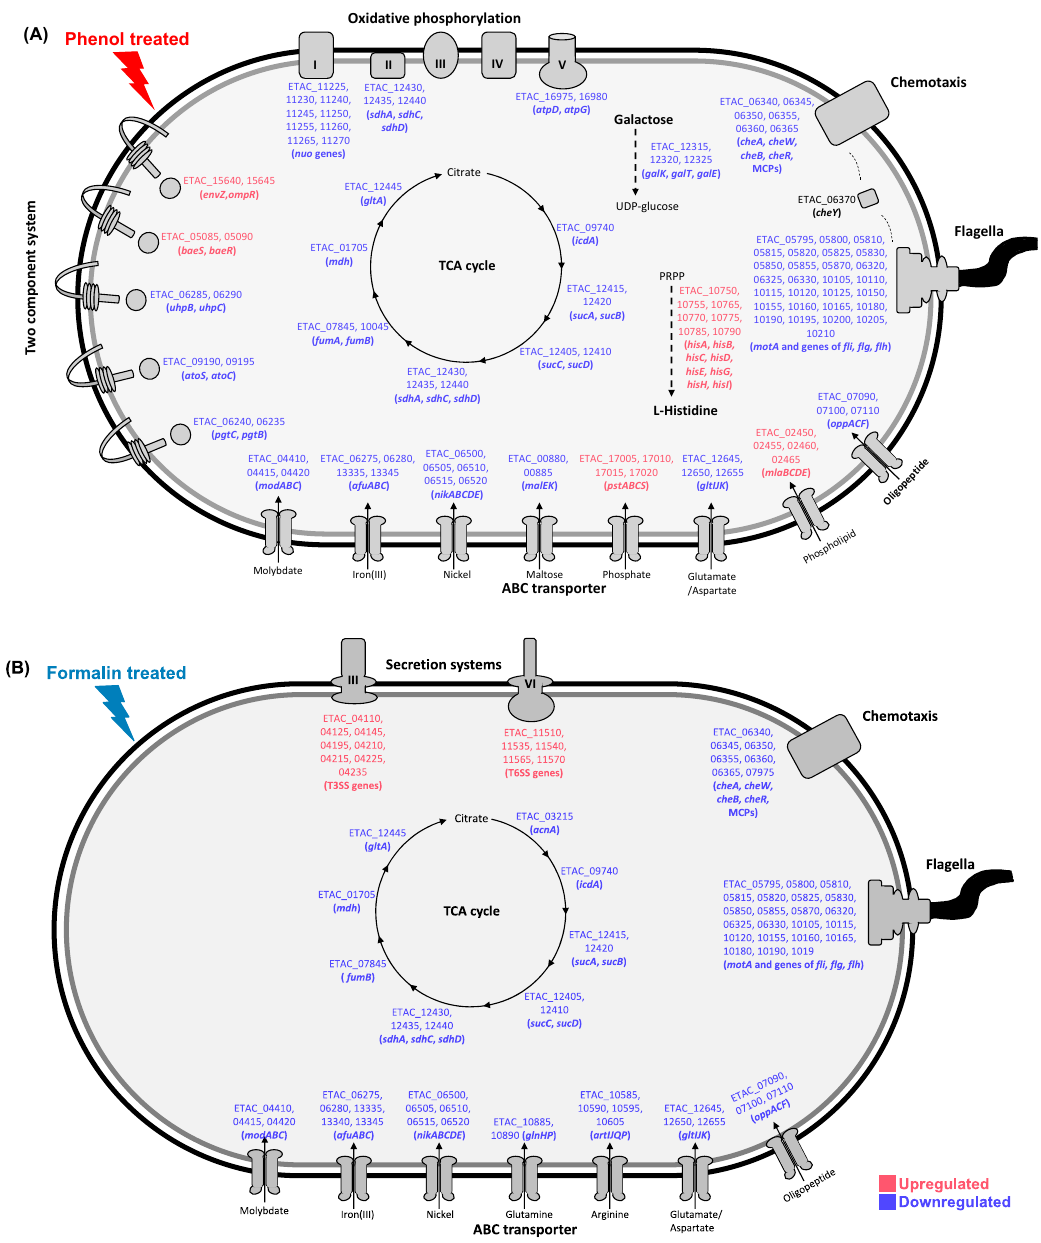
Figure 5. Pathway enrichment analysis based on the Kyoto Encyclopedia of Genes and Genomes (KEGG) database. ( A ) Comparison of DEGs from phenol and non-treated samples. ( B ) Comparison of DEGs from formalin and non-treated samples. Upregulated DEGs and downregulated DEGs are indicated in red and blue, respectively. Proteins and cellular apparatuses are not to scale.